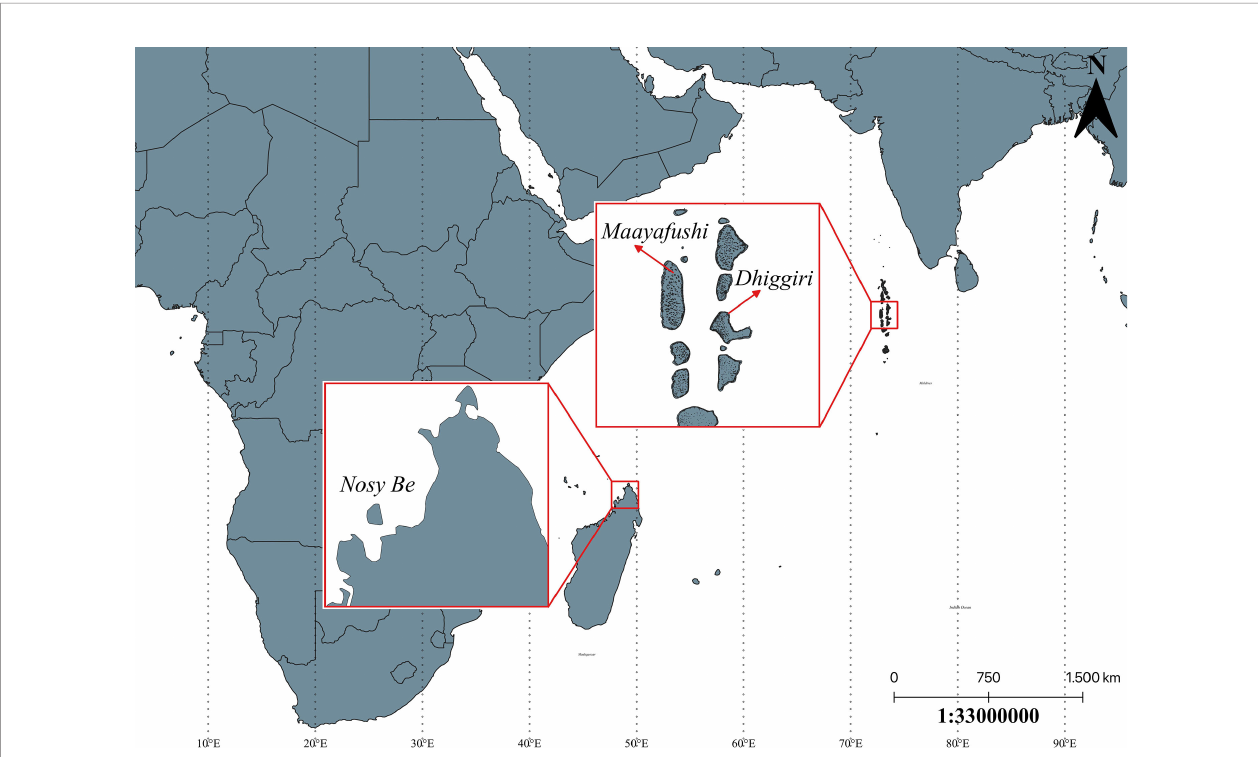
FIGURE 1 | Locations where the Glocal Education project was performed: Nosy Be island, in Madagascar, and Dhiggiri and Maayafushi islands,